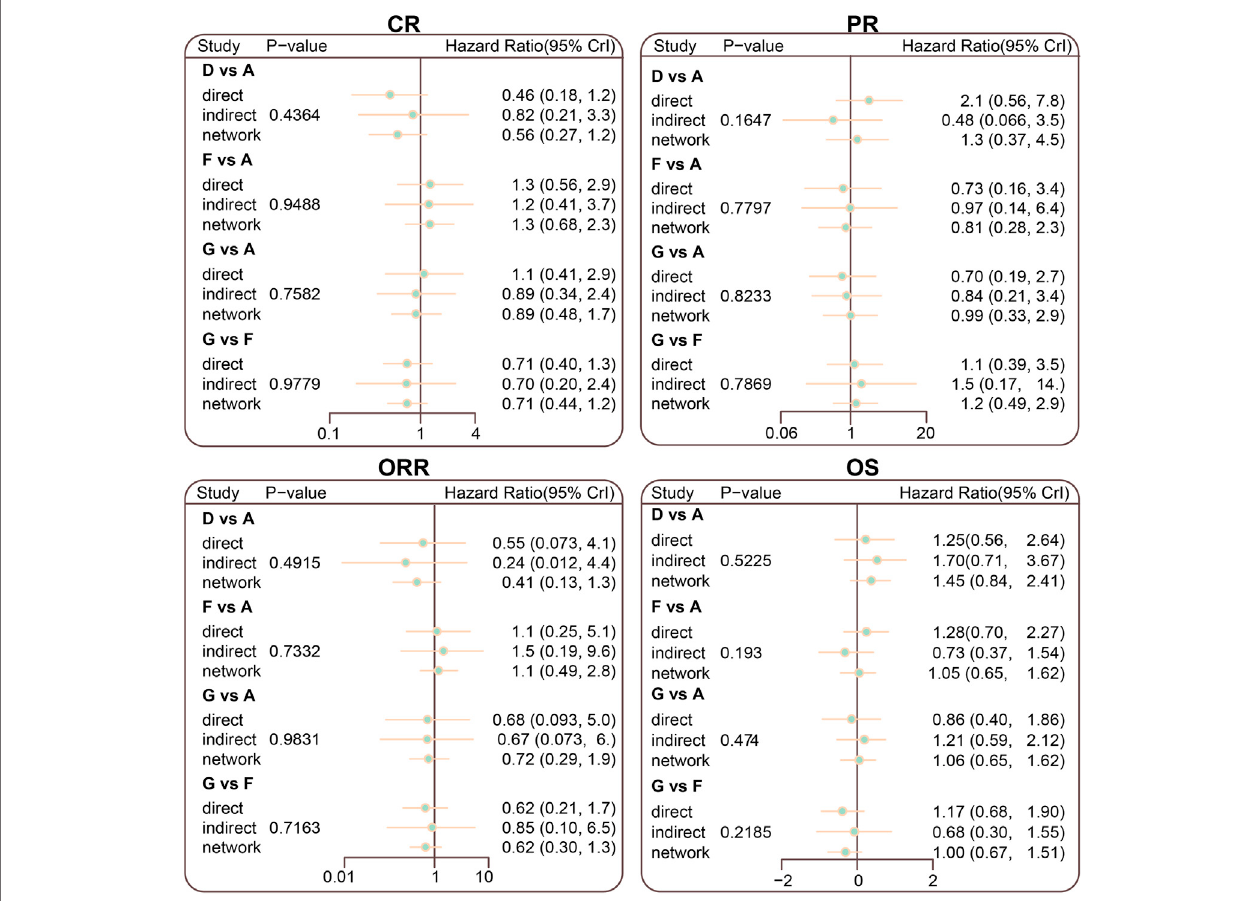
FIGURE 4 | Node splitting diagram for CR, PR, ORR, and OS in advanced HL patients treated with different chemotherapy regimens; A (cid:1) ABVD (doxorubicin + bleomycin + vinblastine + dacarbazine); B (cid:1) BEACOPP (bleomycin + etoposide + doxorubicin + cyclophosphamide + vincristine + procarbazine + prednisone); C (cid:1) StanfordV (doxorubicin+ vinblastine + mechlorethamine + vincristine + bleomycin + etoposide +prednisone); D (cid:1) MOPP (mechlorethamine + vincristine + procarbazine +prednisone);E (cid:1) COPP+ABVD(cyclophosphamide+vincristine+procarbazine+prednisone+doxorubicin+bleomycin+vinblastine+dacarbazine);F (cid:1) MOPP + ABV (Hybrid) (mechlorethamine + vincristine + procarbazine + prednisone + doxorubicin + bleomycin + vinblastine); G (cid:1) MOPP + ABVD (Alternating).